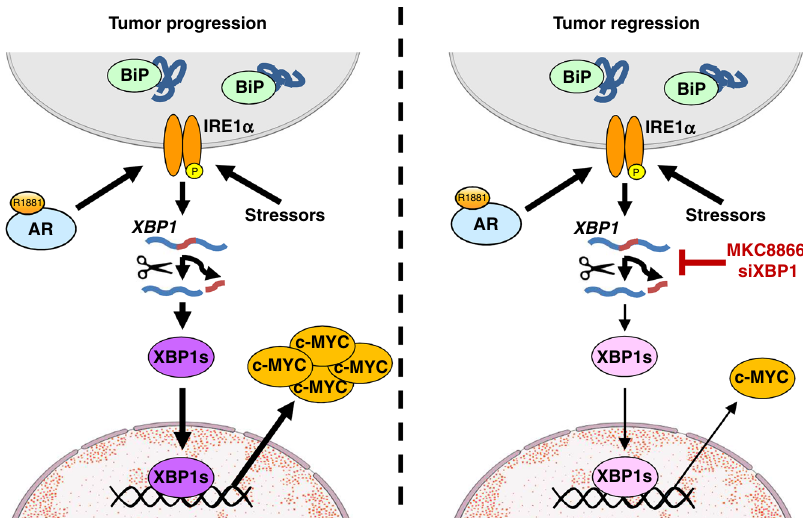
Fig. 6 A schematic summary of the present fi ndings. In PCa cells, the androgen receptor (AR) directly activates IRE1 α expression, that can also be induced by various stressors on the cell. IRE1 α then splices XBP1 mRNA and allows for XBP1s generation. XBP1s transcriptionally induces c-MYC expression, a potent oncoprotein that contributes to tumor progression (left panel). MKC8866 or siXBP1 inhibit XBP1s expression, resulting in signi fi cantly decreased c-MYC levels leading to tumor regression (right